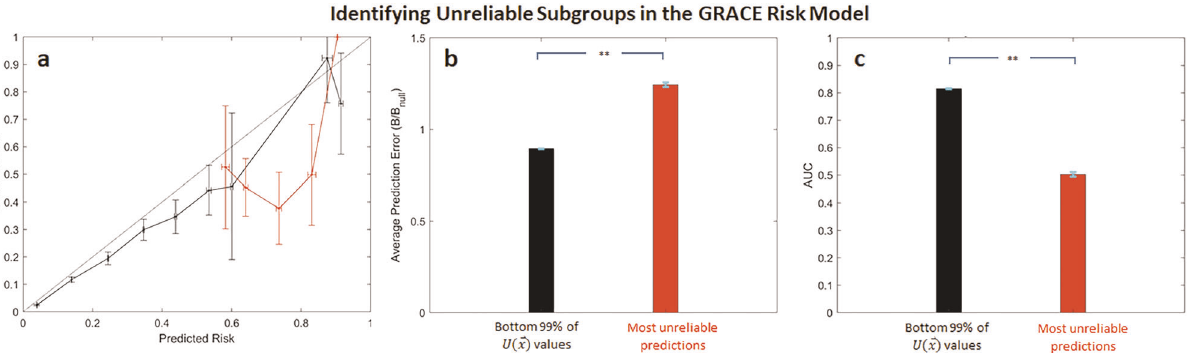
* Þ Fig. 3 The most unreliable predictions (predictions within the top 1% of U ð x values) in the GRACE risk model are associated worse performance. a Calibration curves, b normalized Brier scores, and (c) AUCs for the most unreliable predictions (red) and those that fall within * Þ the bottom 99% of U ð x values (black). ** p << 0.0001. Error bars are from 100 bootstrap splits and show one standard deviation ( a ) or one standard error of the mean ( b and c ). Error bars are truncated at